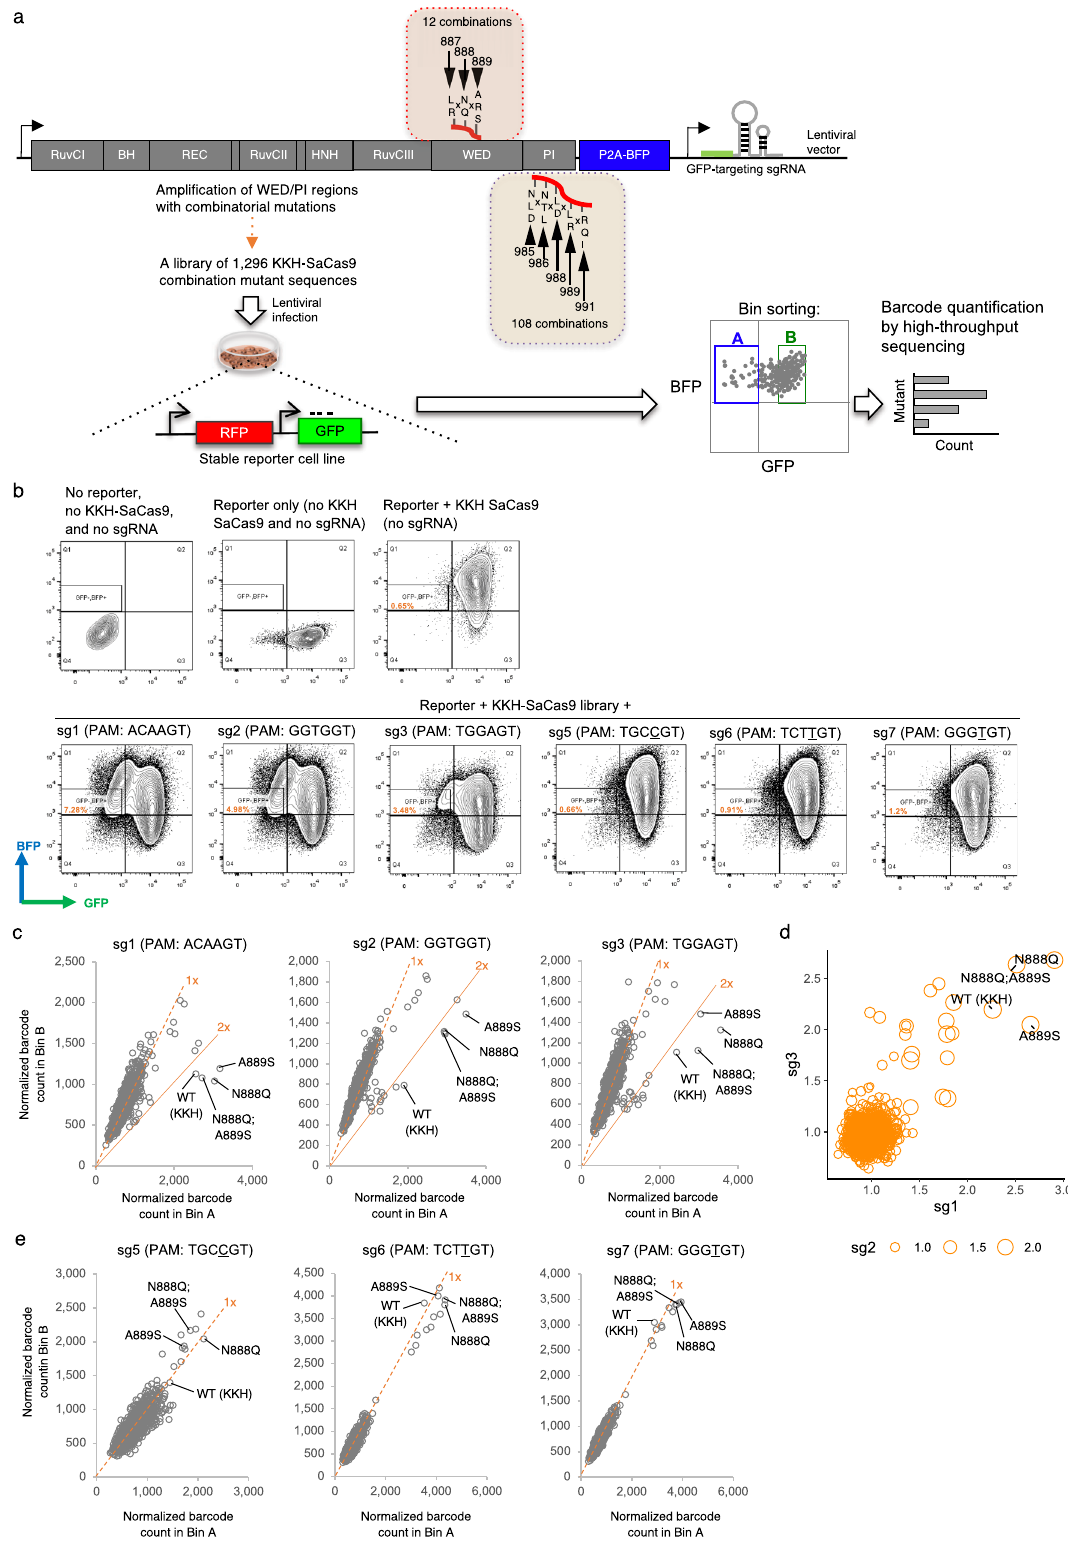
KKH-SaCas9-plus) exhibited the greatest editing activity (i.e., 127% of KKH-SaCas9 ’ s activity, averaged from 3 sgRNAs targeting GFP ) (Fig. 4b). Modeling showed that N888Q putatively only added contact with the PI domain via L989, while A889Q was predicted to interact with N986 and D987, as well as adding contacts with the DNA backbone of the PAM duplex (Fig.